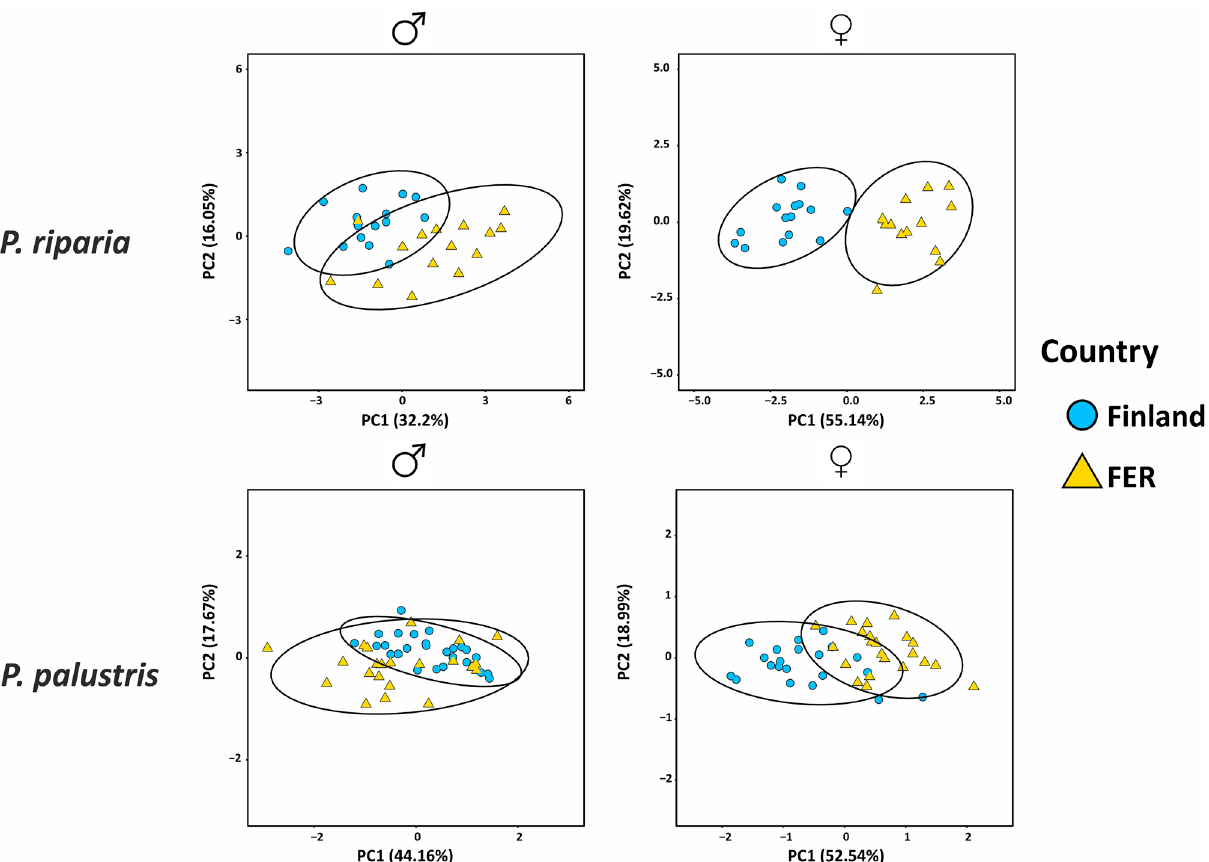
Figure 1. PCA of morphological measurements data for P. riparia and P. palustris . The proportion of the overall variance explained by each PC is shown in parentheses. Areas bordered by the line represent 95% confidence intervals.